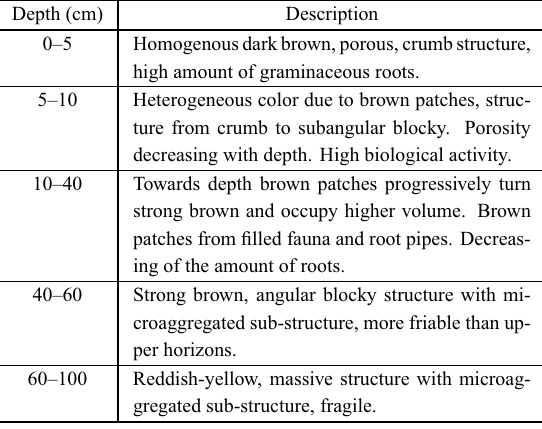
Morphological description of soil in Cunha sampling